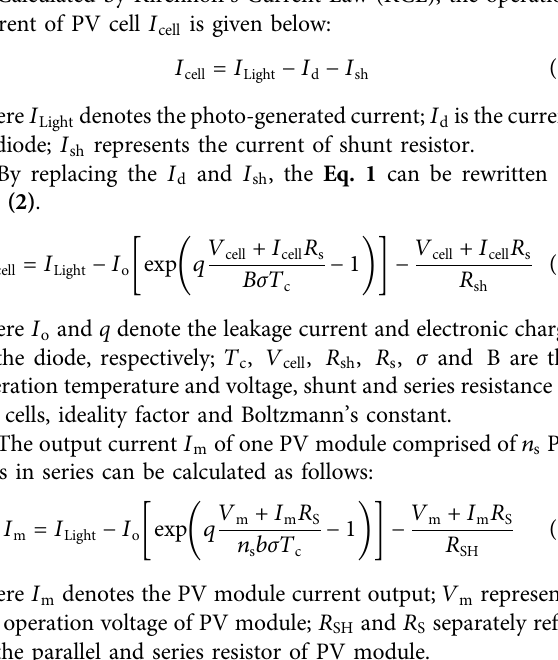
FIGURE 2 | One 9 × 9 TCT array in a PV